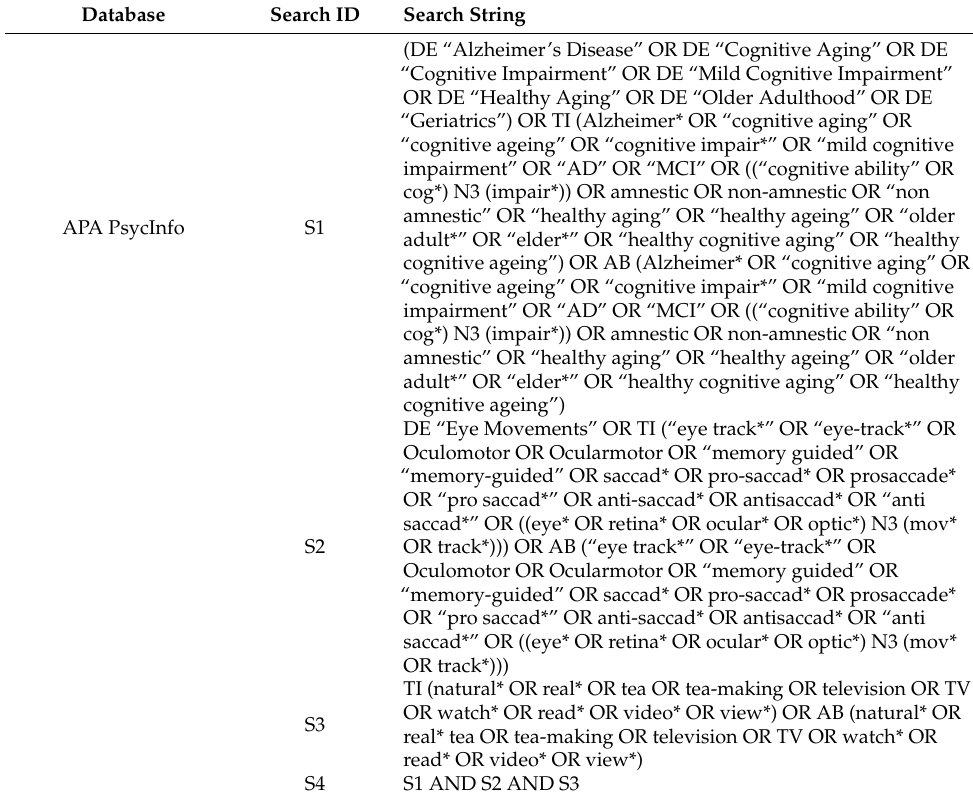
Table A1. Final search strings used for the three databases, accessed through Lancaster